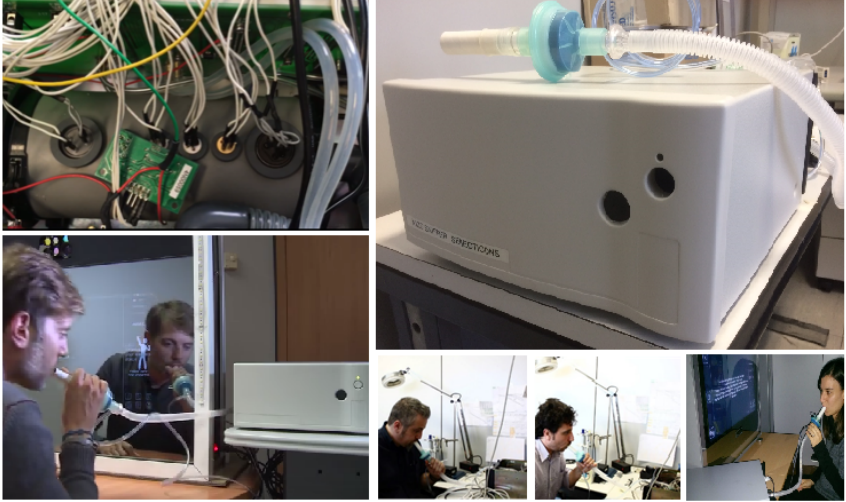
Figure 1. The Wize Sniffer (WS). On the top, left: the gas sensors in the gas sampling chamber are shown. On the top, right: WS external configuration (WS dimensions: 30 cm × 30 cm × 14 cm). Others: the WS while performing a breath